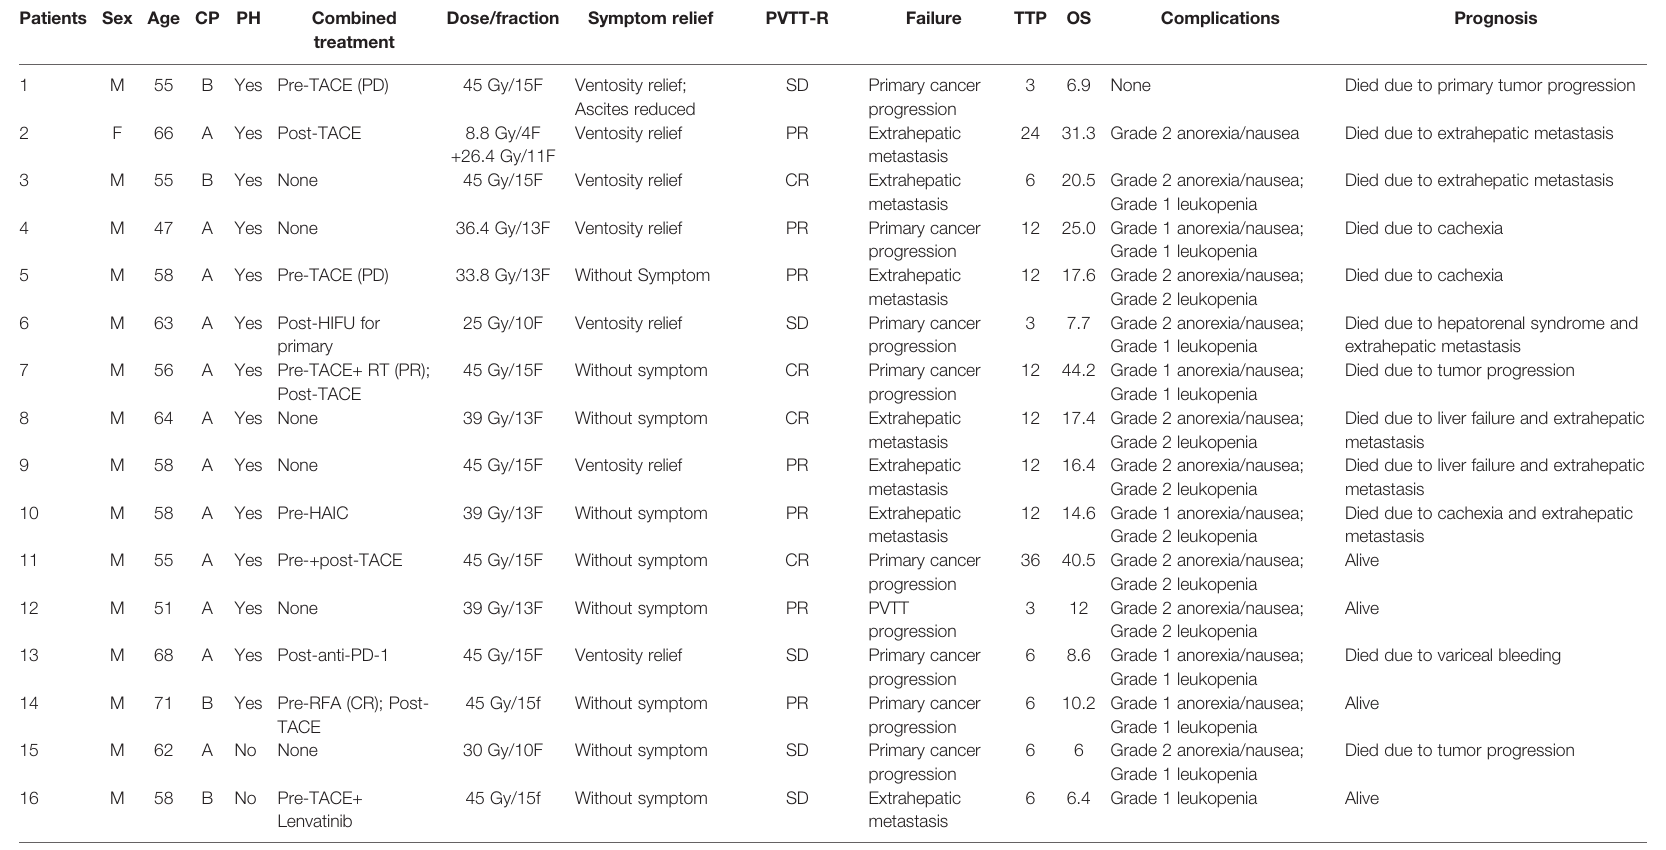
TABLE 1 | Summary of the 16